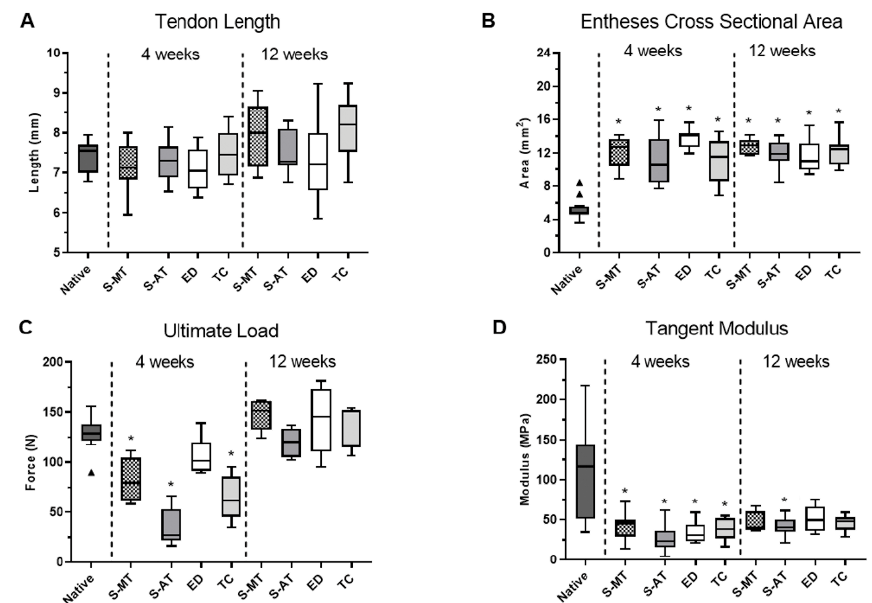
Figure 2. Measurements and mechanical testing of the samples at 4 and 12 weeks after surgery. ( A ) Tendon length, ( B ) enthesis cross sectional area, ( C ) ultimate load, and ( D ) tangent modulus. Tukey’s box plots show 1st and 3rd quartile, median and outliers from eight samples. Significant differences with respect to the native tissue are shown. Obtained p values are indicated as * for p < 0.05 and outliers are indicated by ( ▲ ).